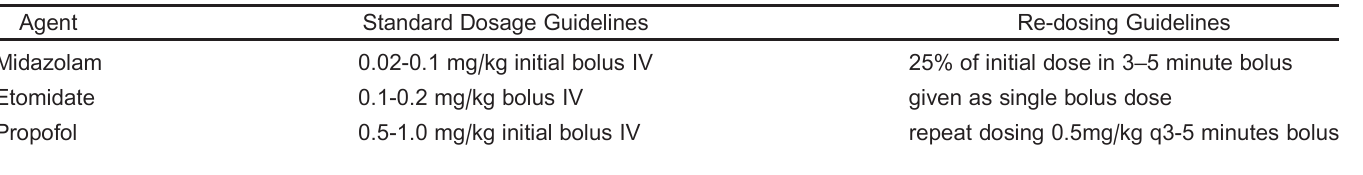
Table 1. Sedation agent dosage guidelines.